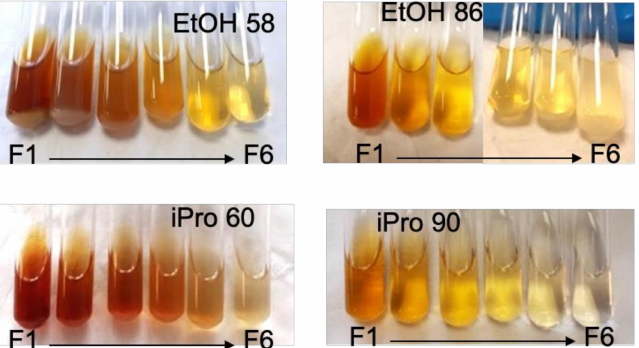
Figure 5. Visual aspect of fractions collected during extraction experiments, from the beginning of the extraction (F1) to its end (F6).